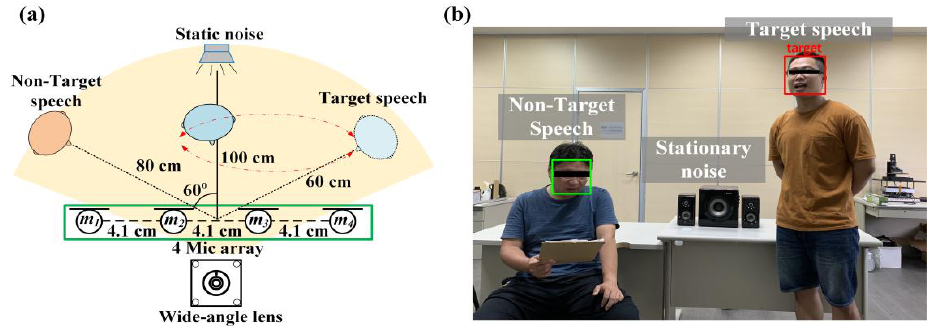
Figure 11. ( a ) Simulation experiment environment schematics; ( b ) Actual multiple noises and moving target.